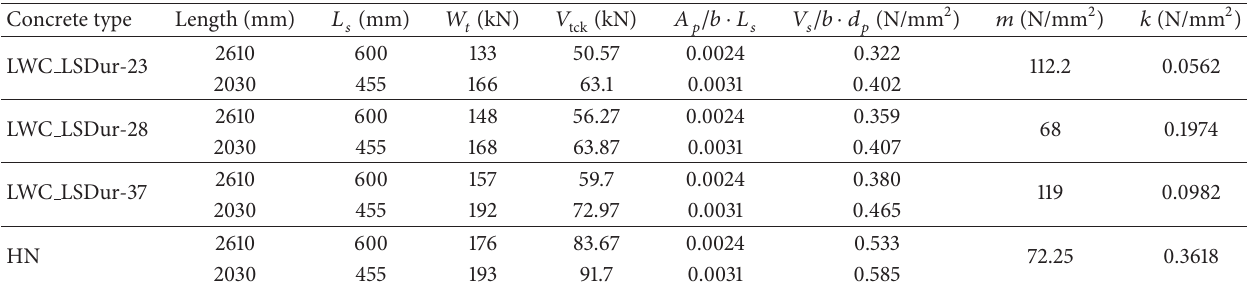
Table 6: m - k tests results.